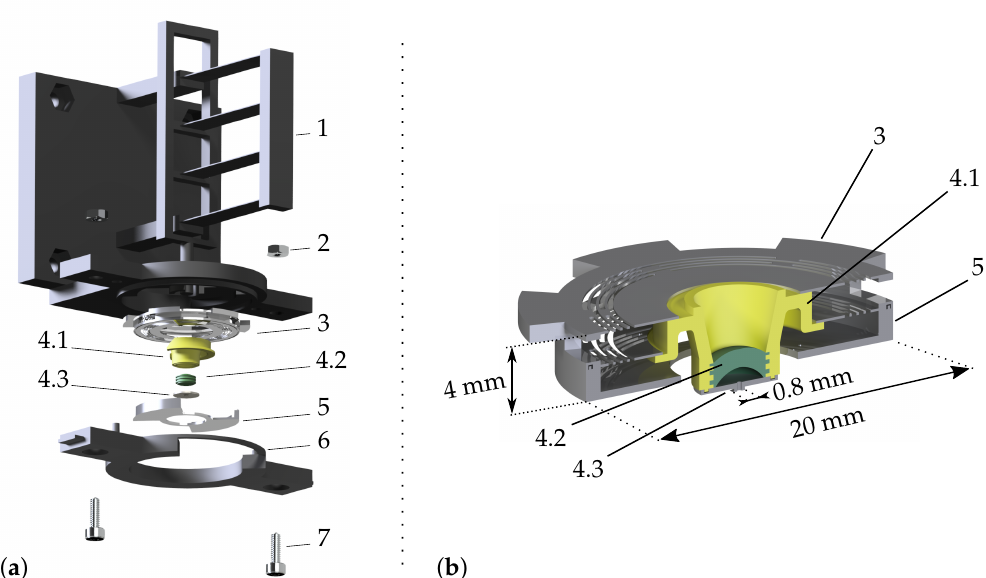
Figure 3. CAD representation of the manufactured parts. ( a ) Exploded view of the system with the order of assembly. The gripper’s core (the body 4.1 in which the cavity 4.2 was molded and closed by the micro-metric picking head 4.3) was assembled with the monolithic parallel ortho-planar springs 3 and enclosed by the lower stops 5. The system was sealed by screwing the lower casing 7 on the interface 1. ( b ) Cut view of the gripper’s core (4.1, 4.2, 4.3) attached to the ortho-planar springs 3 and the lower stops